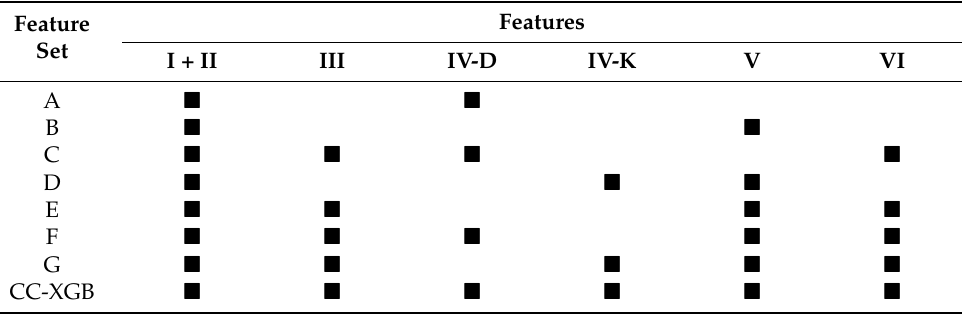
Table 5. Feature set